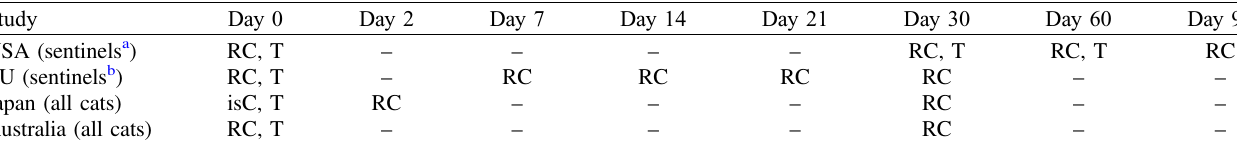
Table 2. Study schedules.